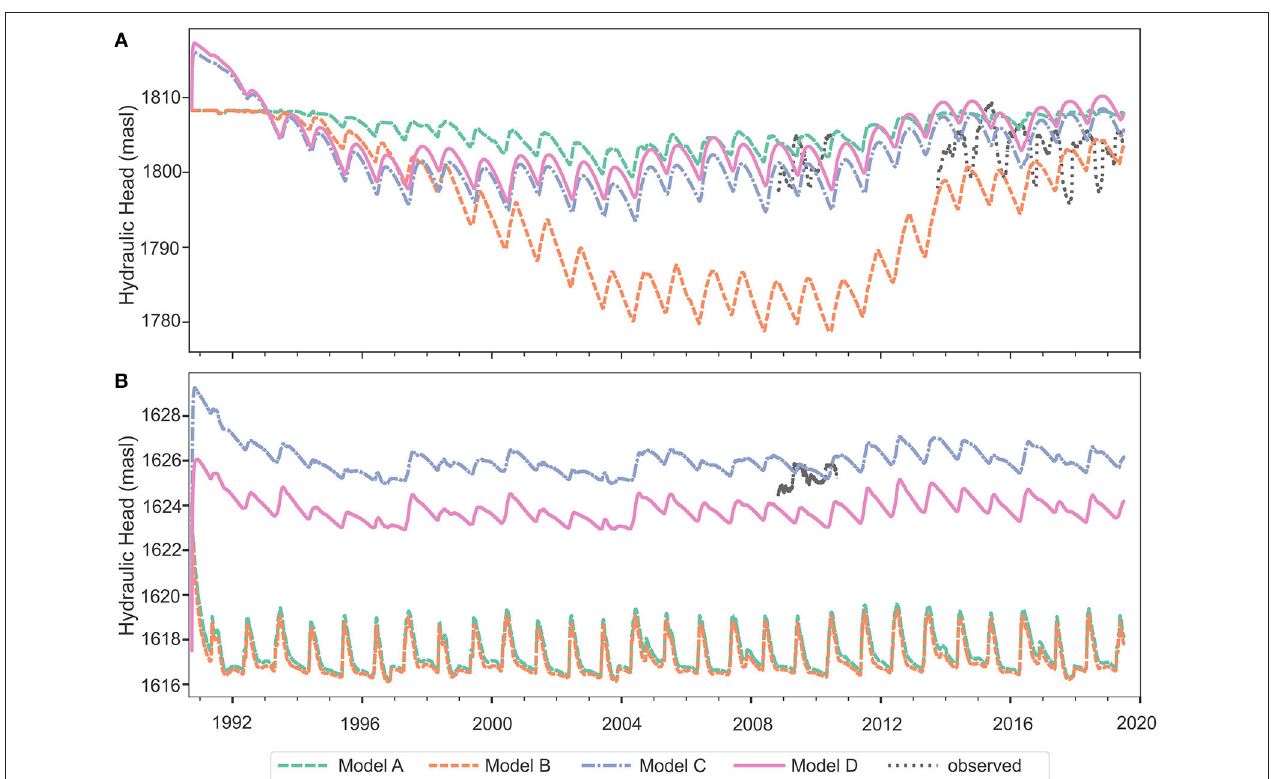
FIGURE 10 | Observed and simulated groundwater levels in (A) W2 and (B) W3 for the period October 1, 1990 to July 1, 2019.